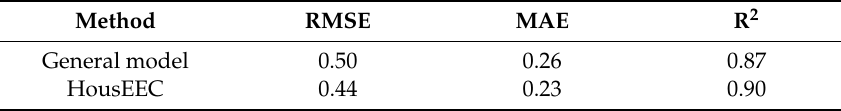
Table 7. Comparison of performance of general and HousEEC